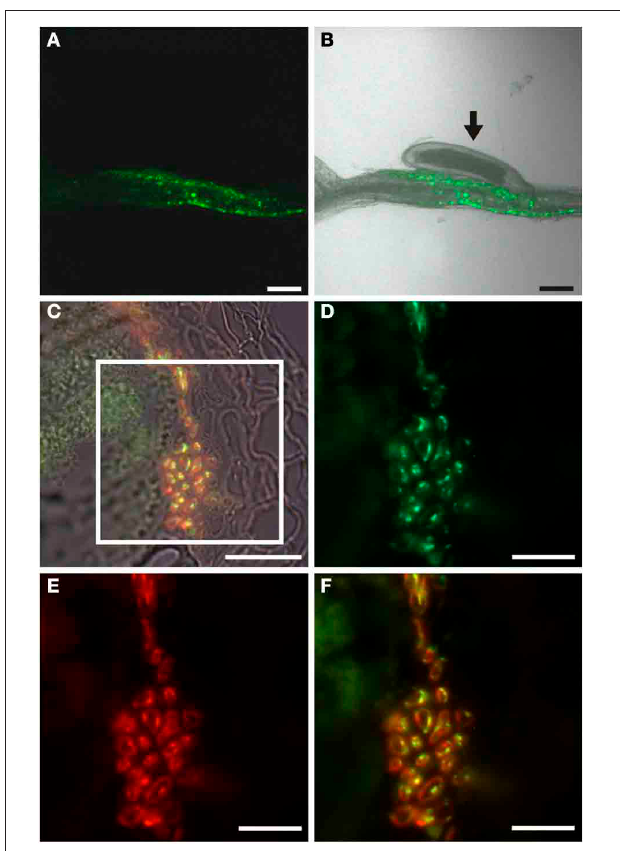
FIGURE 11 | Cytokinin response in roots of H. schachtii -infected P TCS :ER - GFP Arabidopsis plants 14dai. (A,B) GFP fluorescence in intact syncytia. (A) GFP fluorescence, (B) Overlay of GFP fluorescence and bright field image, arrow points to the nematode. (C) Bright field image of a section through a syncytium 14 dai. (D–F) is a detail of the indicated position in (C) . (D) Cytokinin responsive cells decorated by a GFP antibody. Green color results from a Cy2-conjugated secondary antibody. (E) Cells decorated with the sieve element marker antiserum RS6. Red color results from a Cy3-conjugated secondary antibody. (F) is an overlay of (D,E) . Scale bars represent 100 µ m in (A,B) , 20 µ m in (C) and 10 µ m in (D – F) .